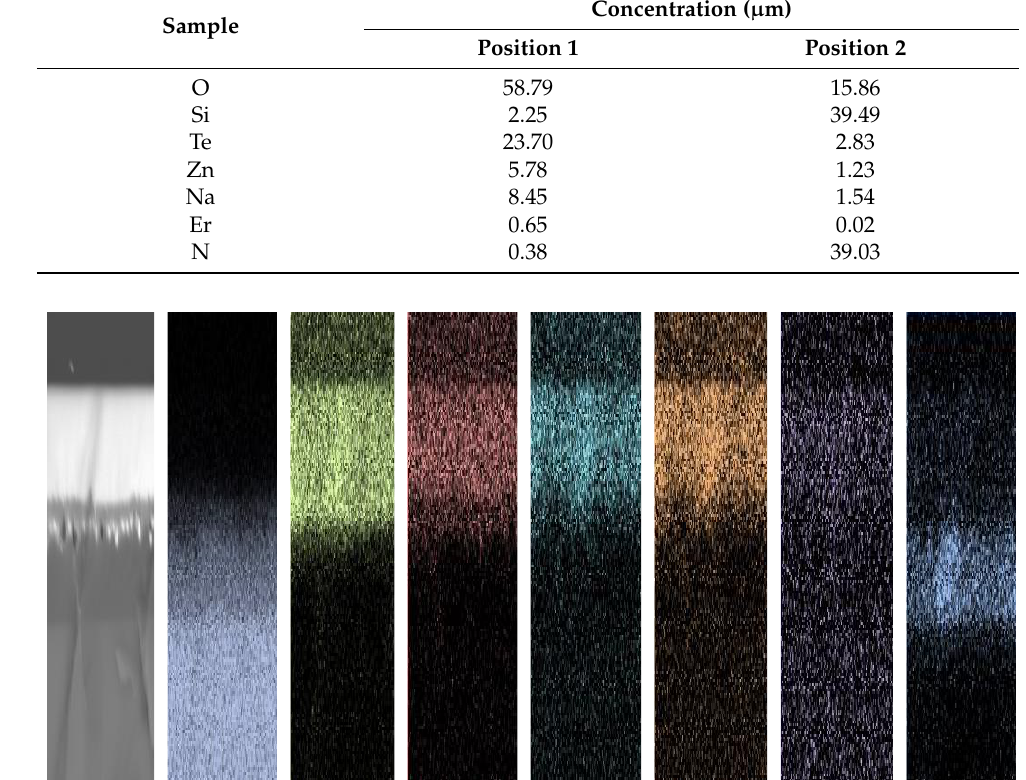
Table 5. The elemental concentration of sample K470 at two locations, as shown in Figure 10.